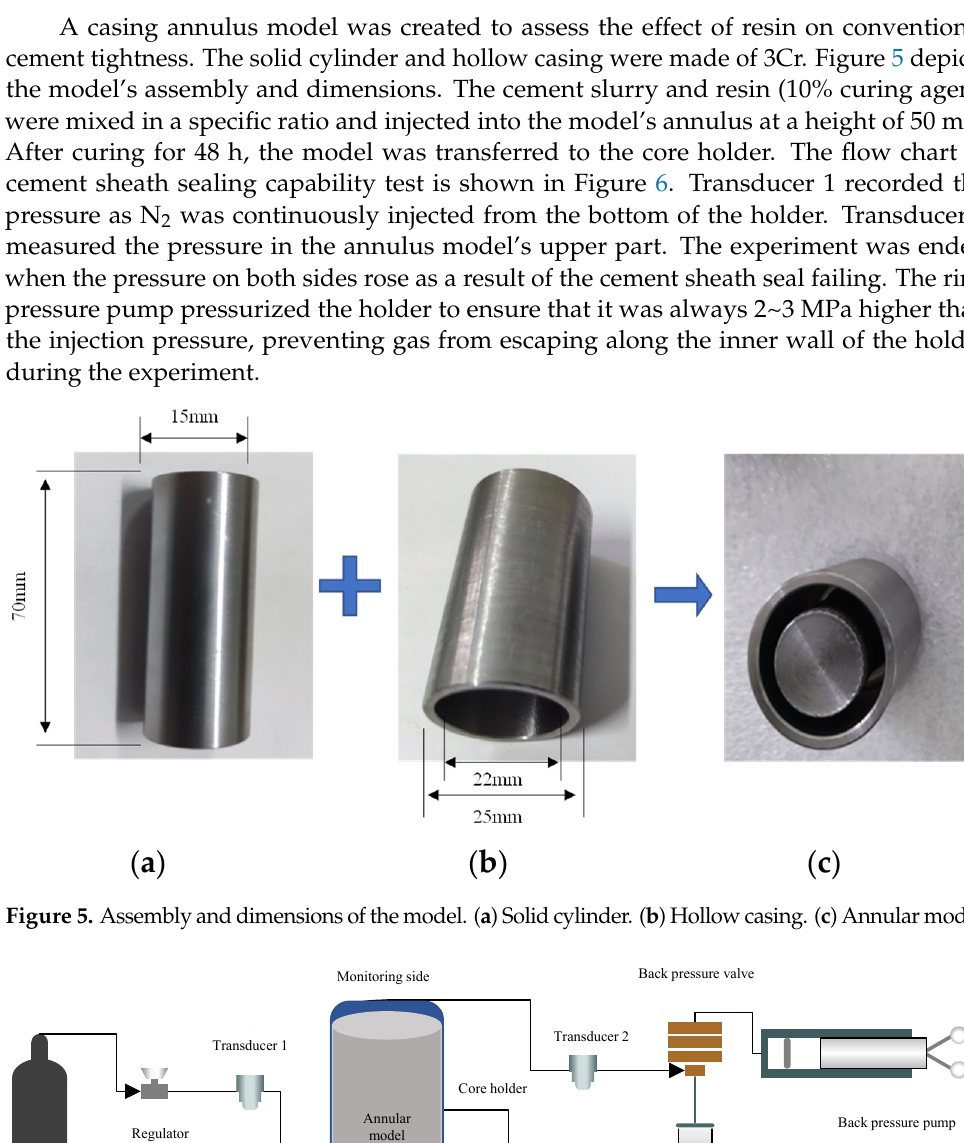
Table 2. Viscosity of E-51 epoxy resin after adding 5% wt viscosity reducer.